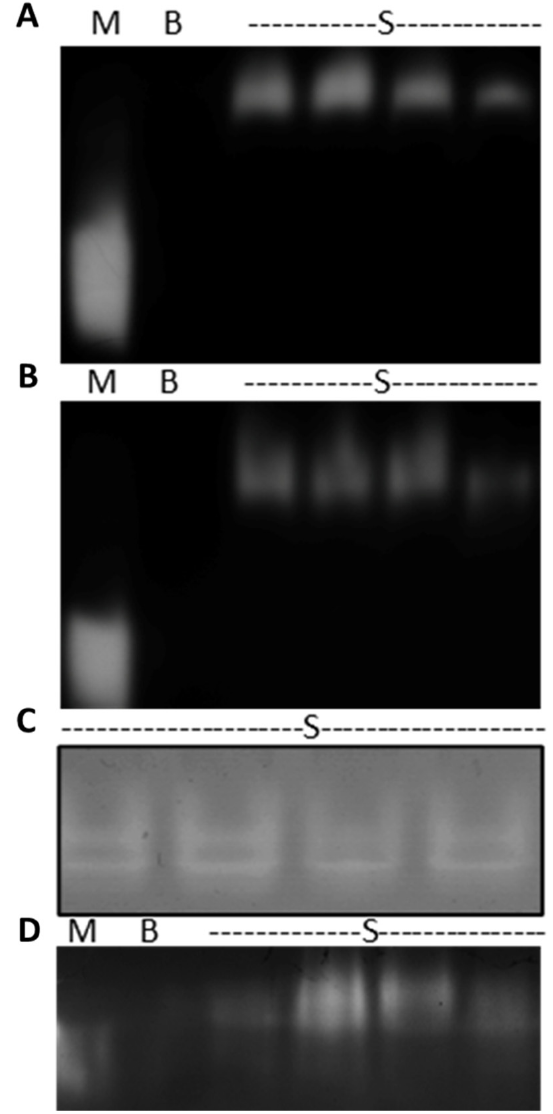
Figure 1. In-gel anti-oxidant assay in Mytilus tissue protein extracts. ( A , B ) Representative native PAGE gels stained for the in-gel activity of CAT in the 20,000 g supernatant ( A ) and pellet ( B ), obtained from digestive gland. Mussel CAT is visible much above the bovine liver commercial standard. ( C ) Representative in-gel assay for SOD. Two bands are always visible. ( D ) Representative in-gel assay for GPX. Mussel GPX is visible just above the bovine erythrocyte GPX commercial standard. Legend: M, commercial marker; B, blank; S, mussel protein extract (digestive gland) showing some interindividual variability.